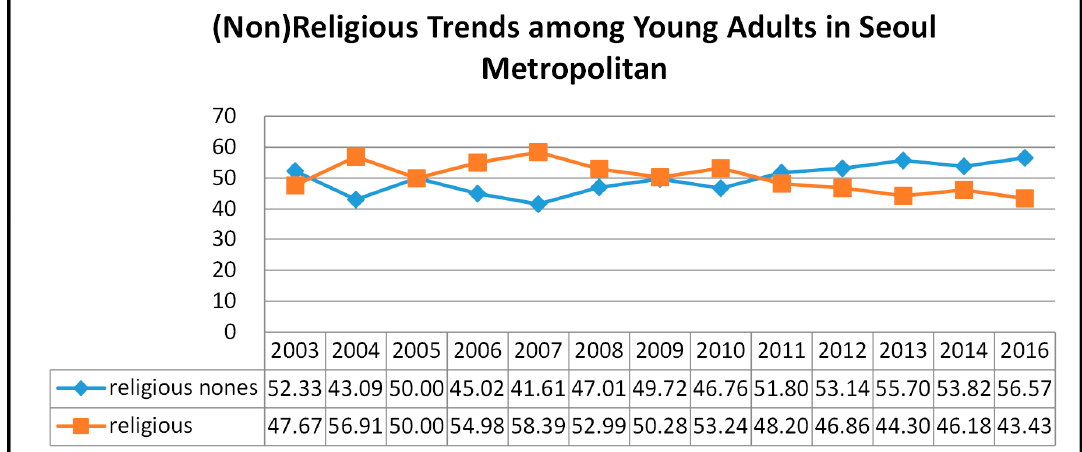
Figure 2. Trends among young adults in Seoul Metropolitan: 2003–2016. (%). Source: KGSS 2003~2016.